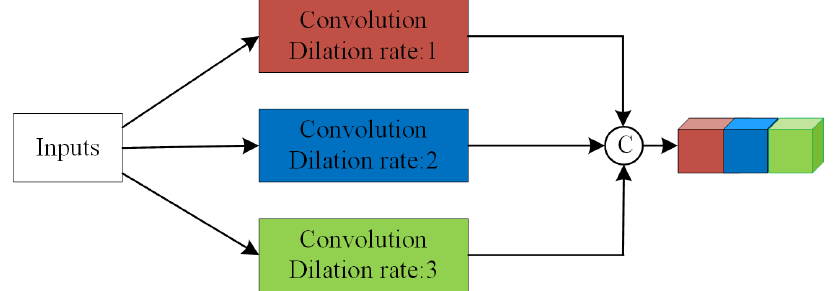
Figure 3. The framework of the CSDC